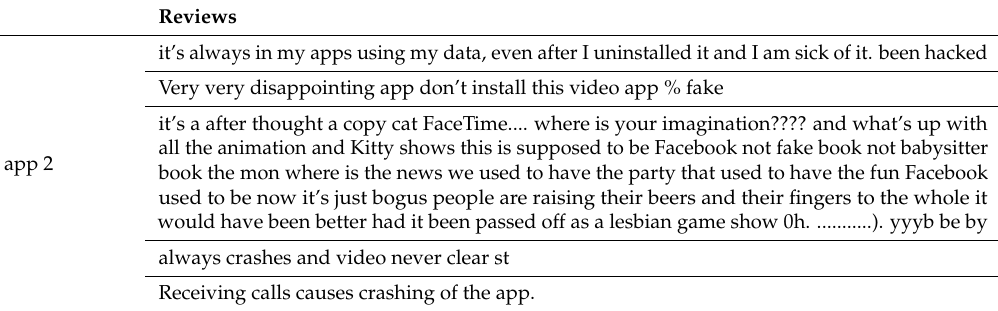
Table 9. Security-related reviews of app ID